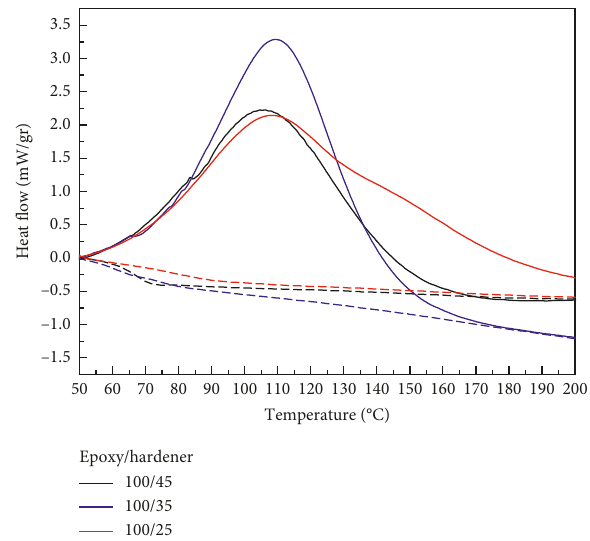
Figure 5: DSC scans for the different epoxy/hardener systems investigated, full line during curing (first heating), dash line after curing (second